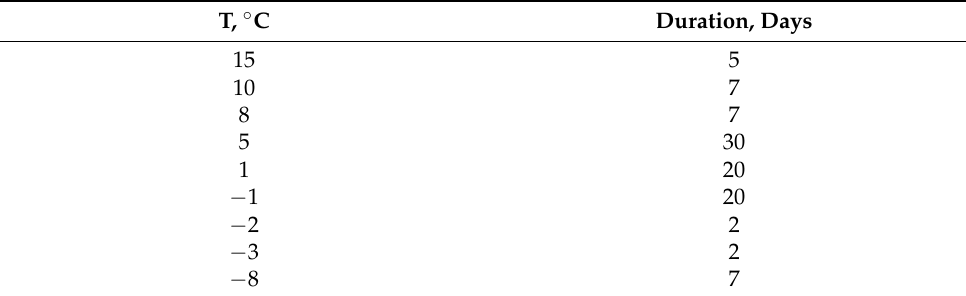
Table 1. Freezing protocol for the Siberian